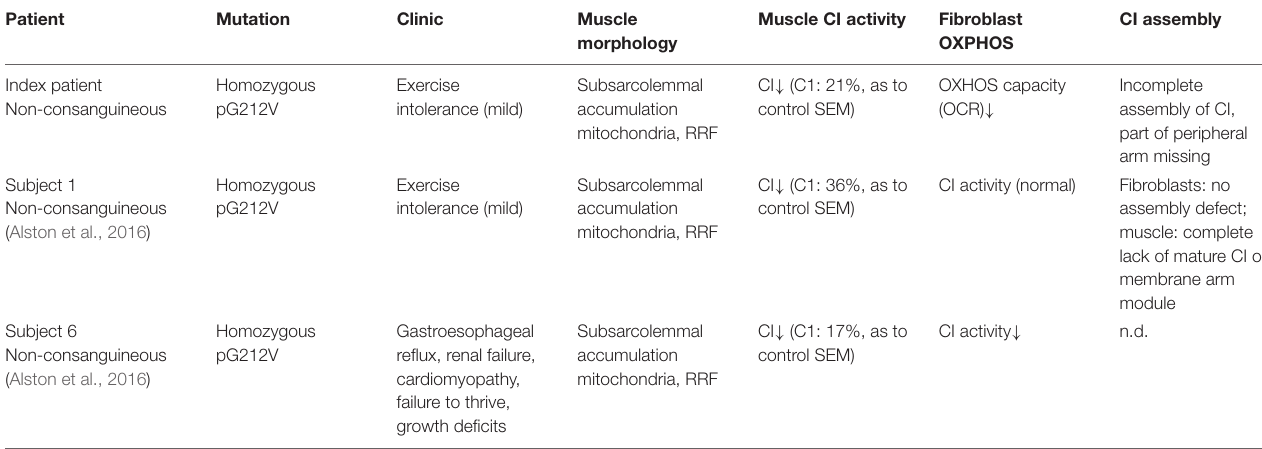
TABLE 2 | Clinical and biochemical characteristics of the homozygous p.G212V TMEM126B patients.